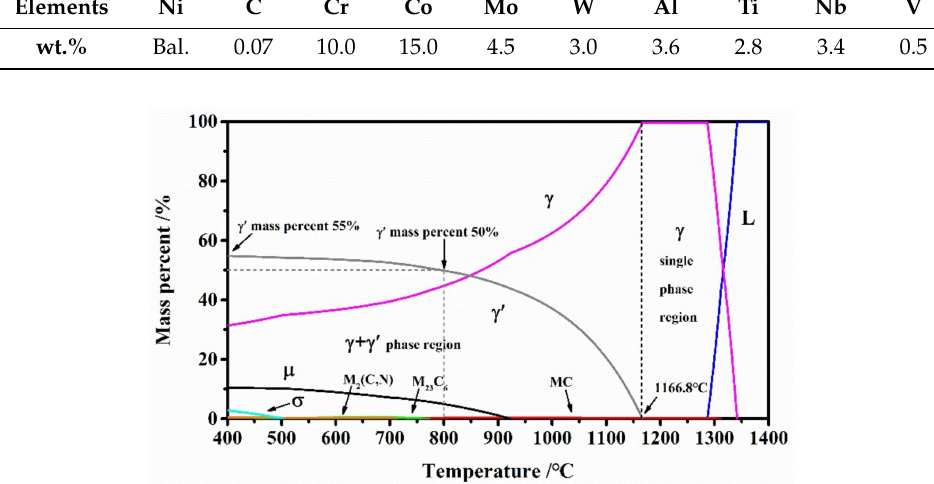
Figure 1. Phase transition diagram of GH4151 alloy plotted by JMatPro software.